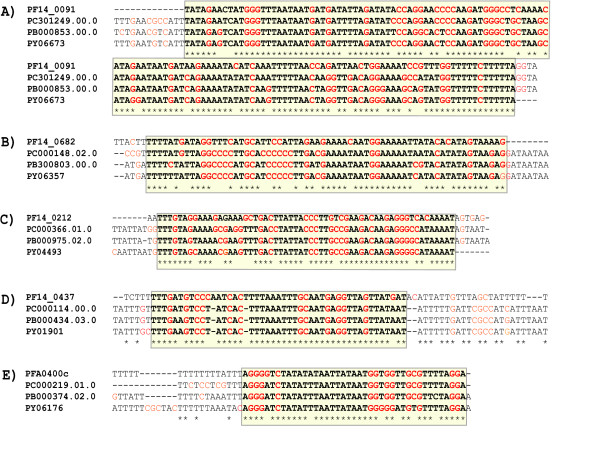
Upstream blocks conserved beyond neutral expectations among P. falciparum and the three mouse malaria species. These blocks were identified by searching the aligned regions upstream of orthologous genes and are strong candidates for having novel functions. These are (A) at 275 bp upstream of PF14_0091, a hypothetical gene, (B) at 81 bp upstream of PF14_0682, a hypothetical gene, (C) at 185 bp upstream of PF14_0212, a hypothetical gene, (D) at 275 bp upstream of PF14_0437, a helicase truncated putative gene, and (E) at 1 bp upstream of PFA0400c, a beta3 protesome putative gene. In total, we observe 81 P. falciparum 5' regions with a conservation p-value of 10-6or lower.